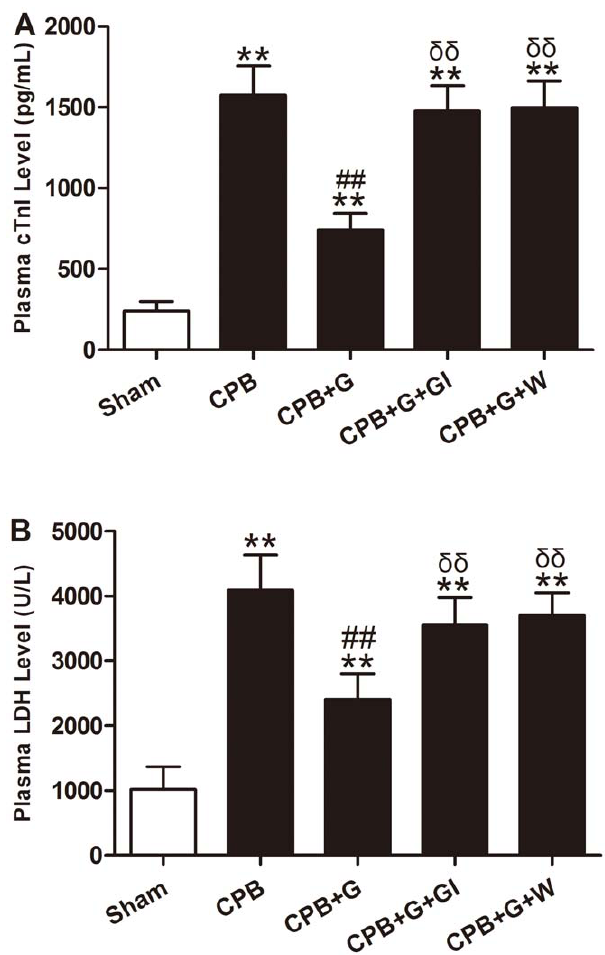
Figure 1. Myocardial injury in rats subjected to cardiopulmo- nary bypass (CPB) with different treatments (n=8/group). Values presented are mean 6 SEM. A: serum cardiac troponin I (cTnI) level. B: serum lactate dehydrogenase (LDH) level. G, ghrelin; GI,